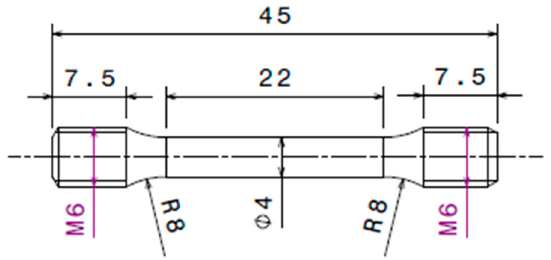
Figure 2. Dimensions of the test specimen extracted from the WAAM IN718 wall and from wrought material.